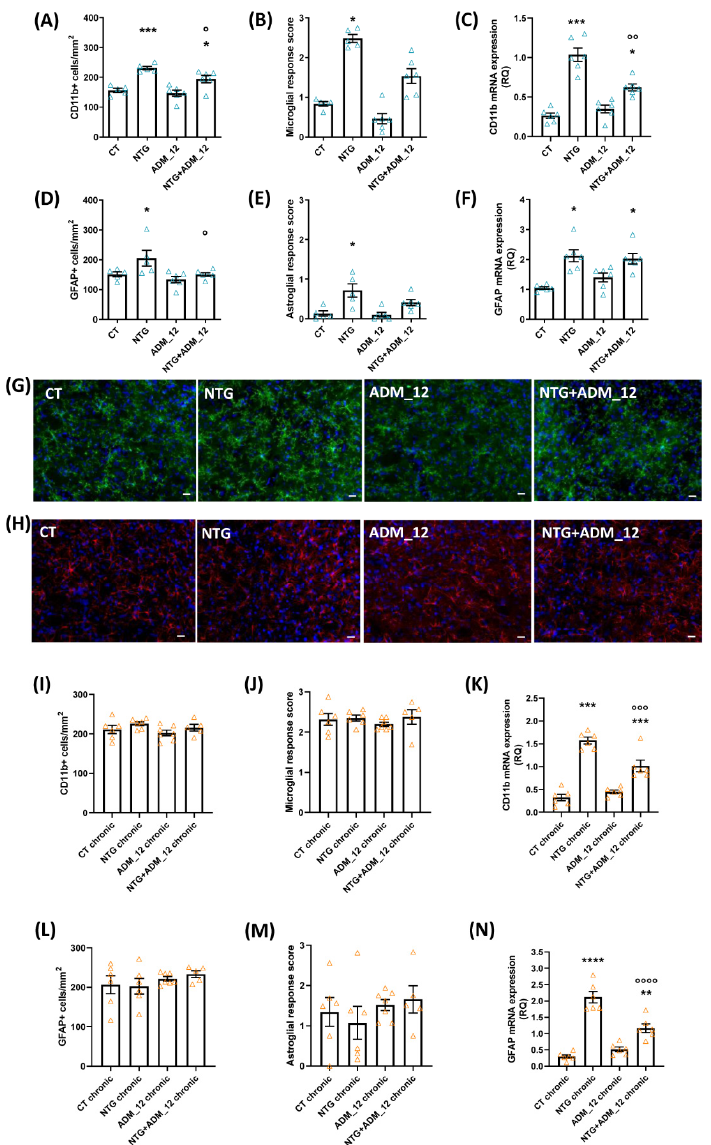
Figure 3. Effects of ADM_12 (30 mg/kg) on the microglial and astroglial activation ipsilateral to formalin injection. Acute migraine model ( A – H ): immunofluorescence analysis in the TNC area of CD11b-positive cells ( A ) and GFAP-positive cells ( D ) per area in mm 2 ( n = 5–6 per group). Microglial ( B ) and astroglial ( E ) response score (see Methods for details). CD11b ( C ) and GFAP ( F ) mRNA levels, expressed as relative quantification (RQ; see Section 4 for details), in the Medulla oblongata containing the TNC ( n = 6 per group). Representative photomicrographs of microglial ( G ) and astroglial ( H ) activation; Blue: DAPI; green: CD11b; red: GFAP. Please refer to Supplementary Figure S2 for the localization of photomicrographs. Scale bars: 20 µ m. CT: Control. * p < 0.05 and *** p < 0.001 vs. CT and ADM_12; ◦ p < 0.05 and ◦◦ p < 0.01 vs. NTG. Chronic migraine model ( I – N ): immunofluorescence analysis in the TNC area of CD11b-positive cells ( I ) and GFAP-positive cells ( L ) per area in mm 2 ( n = 5–7 per group). Microglial ( J ) and astroglial ( M ) response scores (see Methods for details). CD11b ( K ) and GFAP ( N ) mRNA levels, expressed as relative quantification (RQ; see Section 4 for details), in the Medulla oblongata containing the TNC ( n = 6 per group). ** p < 0.01, *** p < 0.001 and **** p < 0.0001 vs. CT chronic and ADM_12 chronic; ◦◦◦ p < 0.001 and ◦◦◦◦ p < 0.0001 vs. NTG chronic. Data are expressed as the mean ± SEM. One way ANOVA followed by Tukey’s multiple comparisons test for ( A , C , D , F , I , K , L , N ) and Kruskal–Wallis test followed by Dunn’s Multiple Comparison Test for ( B , E , J , M